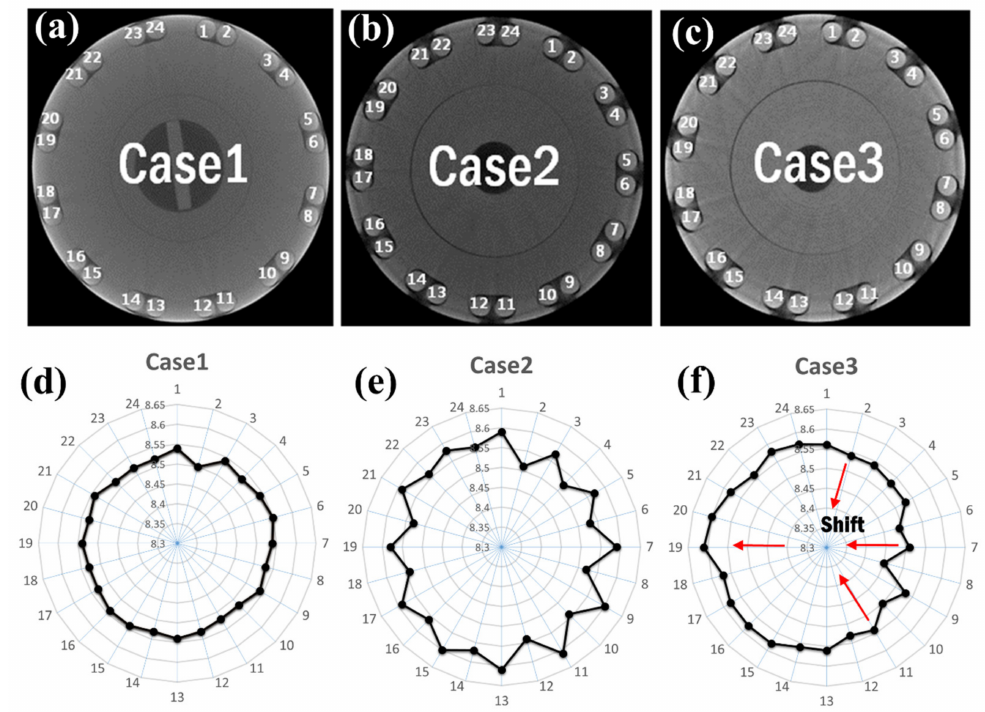
Figure 5. Three-dimensional non-destructive analysis with magnetization yoke (( a , d ) case 1, ( b , e ) case 2, and ( c , f ) case